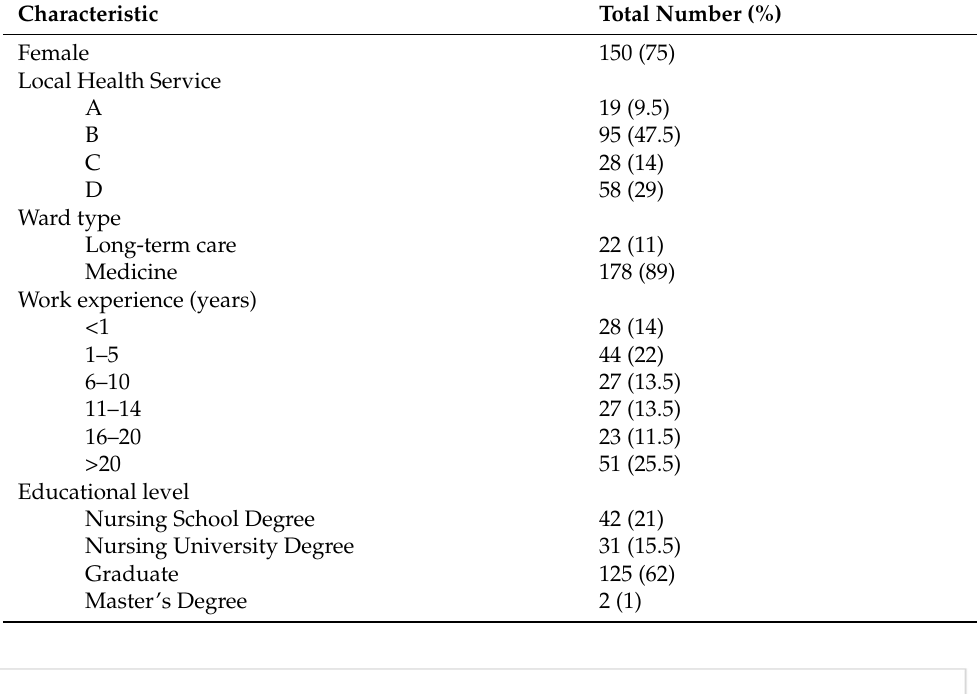
Table 1. Demographic characteristics of the sample (n = 200).